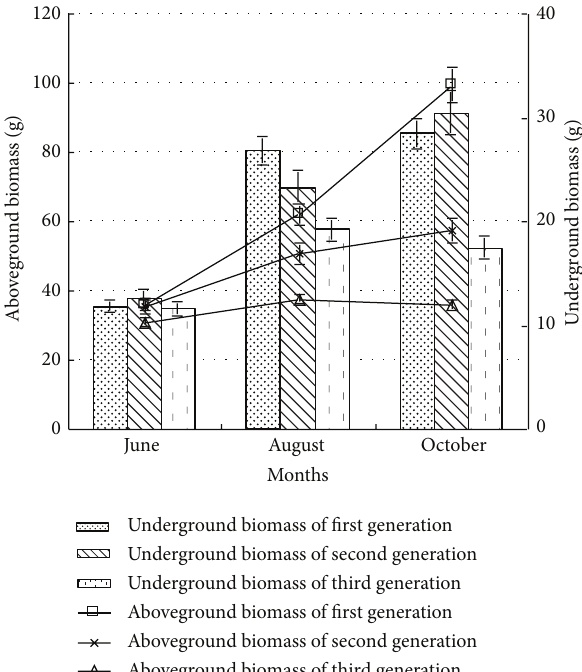
Figure 3: The specific leaf area and leaf area ratio of poplar under different continuous